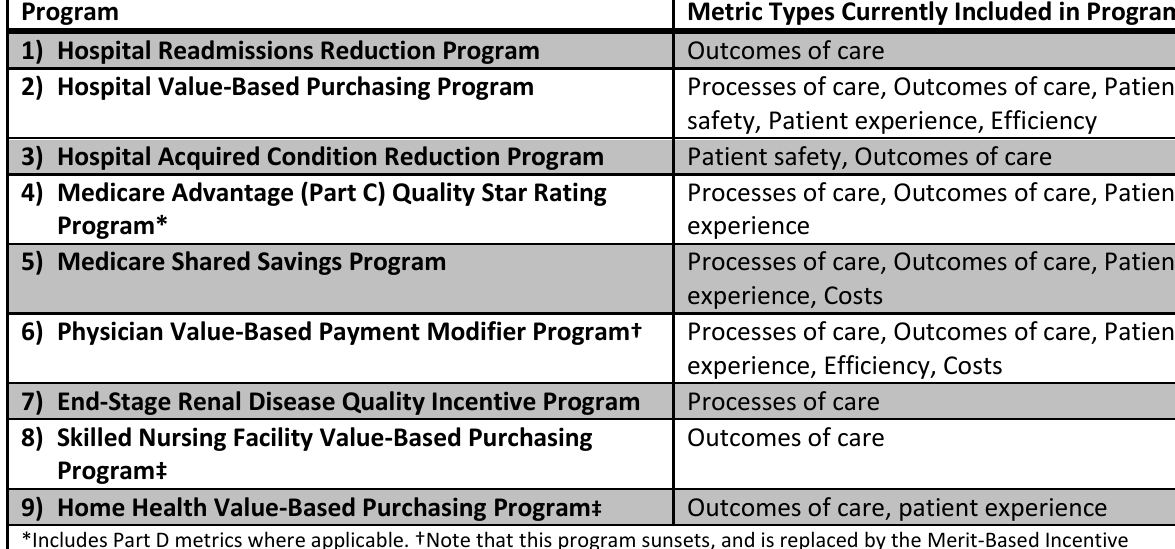
Table 1.1: Medicare Payment Programs Included in this report Program Metric Types Currently Included in